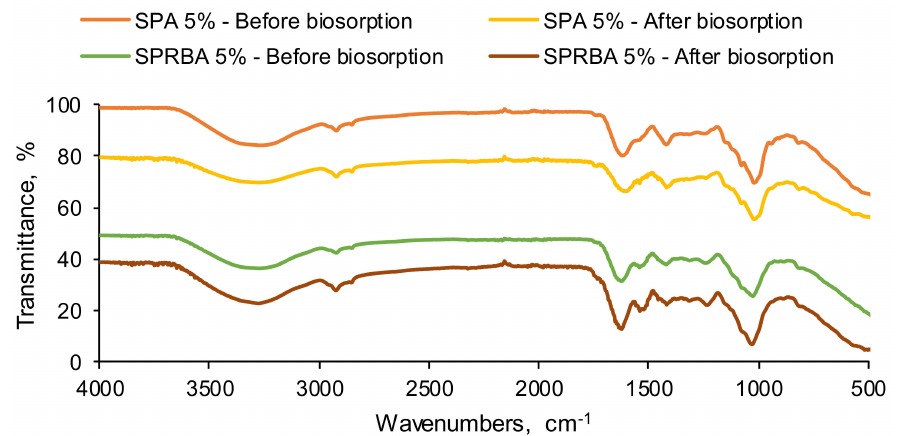
Figure 4. FTIR spectra of SPA 5% and SPRBA 5% biosorbents before and after ethacridine lactate